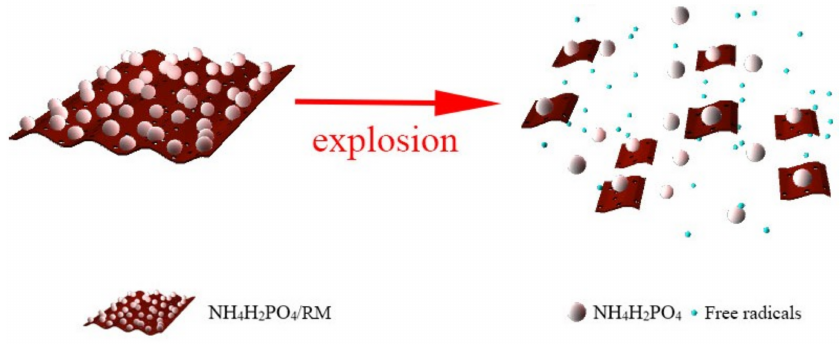
Figure 8. The schematic diagram of the NH 4 H 2 PO 4 /RM composite powders in the explosion process. Physical inhibition effect: The NH 4 H 2 PO 4 /RM composite powders have a good heat